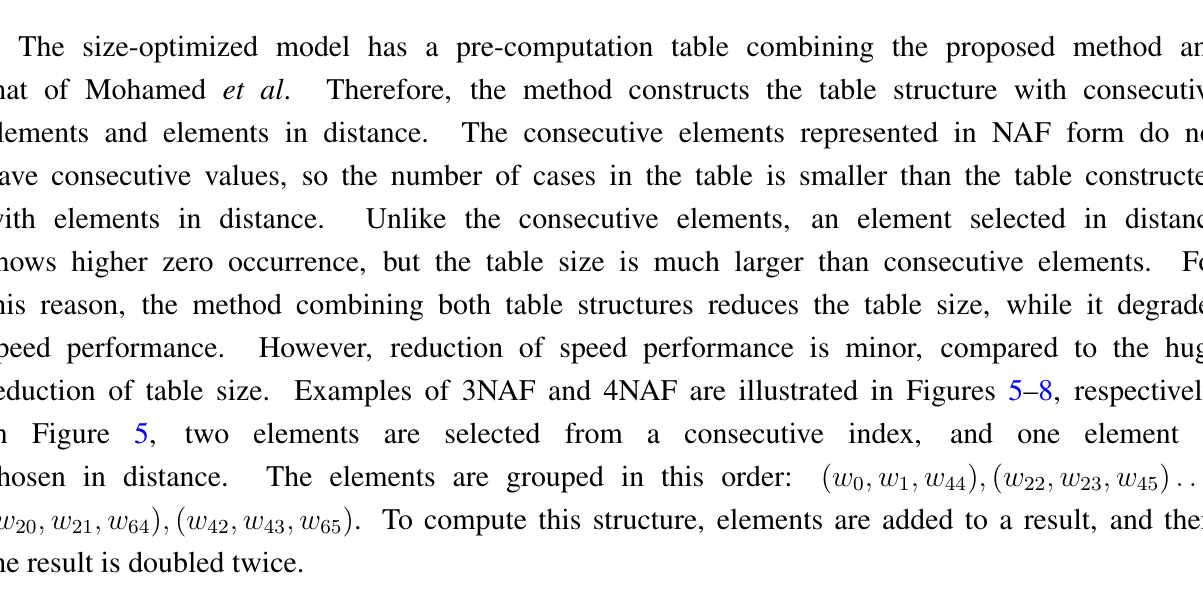
Figure 5. Look-up table structure of (size-optimized) the proposed method in a block form for 3NAF (version 1).